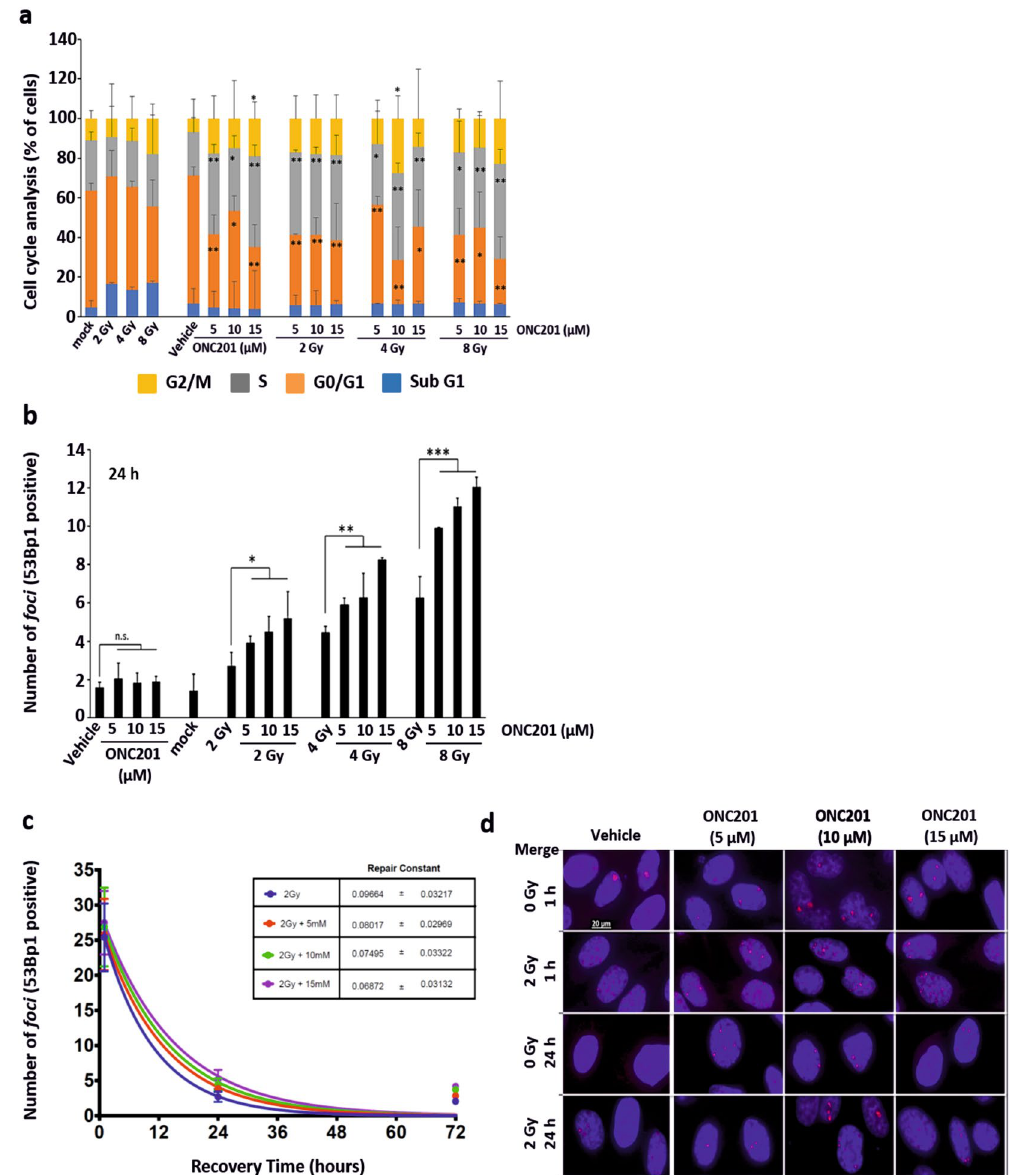
Figure 4. ONC201 determines the accumulation of foci into the nuclei of cells primed to radiation. ( a ) Cell cycle analysis of PC3 cells primed to radiation (Xrad) with ONC201 (5–15 µM) for 24 h showed an expansion of the cell population in S (grey) and G2/M (yellow) phases (n = 3). ( b ) Number of 53Bp1 + foci per cell at 24 h post- irradiation in PC3 cells. Samples were analysed at the time points schematically represented in Fig. 3a (n = 3). ( c ) Analysis of the kinetics of repair from the DNA damage induced by radiation in PC3 cells (n = 3). Samples were treated and analysed at the time points schematically represented in Fig. 3a. ( d ) Immunofluorescence analysis (Merge) of the foci formation, determined through 53Bp1 (red) staining at 1 and 24 h from radiation (representative of n = 3). The total number of foci counted is represented in panel ( b ). One-way ANOVA test has been run. The data shown in panel ( b ) have been run through ANOVA test on Ranks and further analysed with Dunnett’s Method. *p ≤ 0.05; **p < 0.01; ***p < 0.001 (±